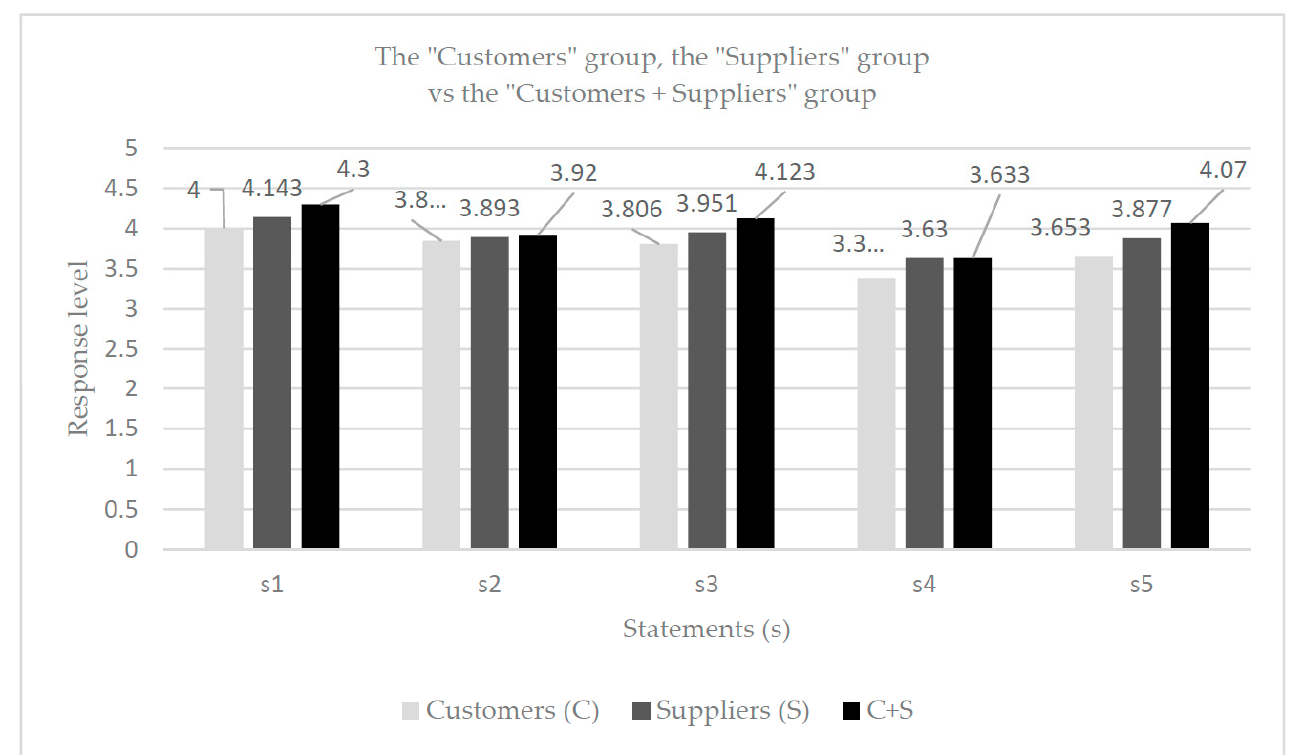
Figure 7. Comparison of statements (s) presented by representatives of enterprises in the Groups: Customers (C), Suppliers (S), and Customers and Suppliers (C + S).